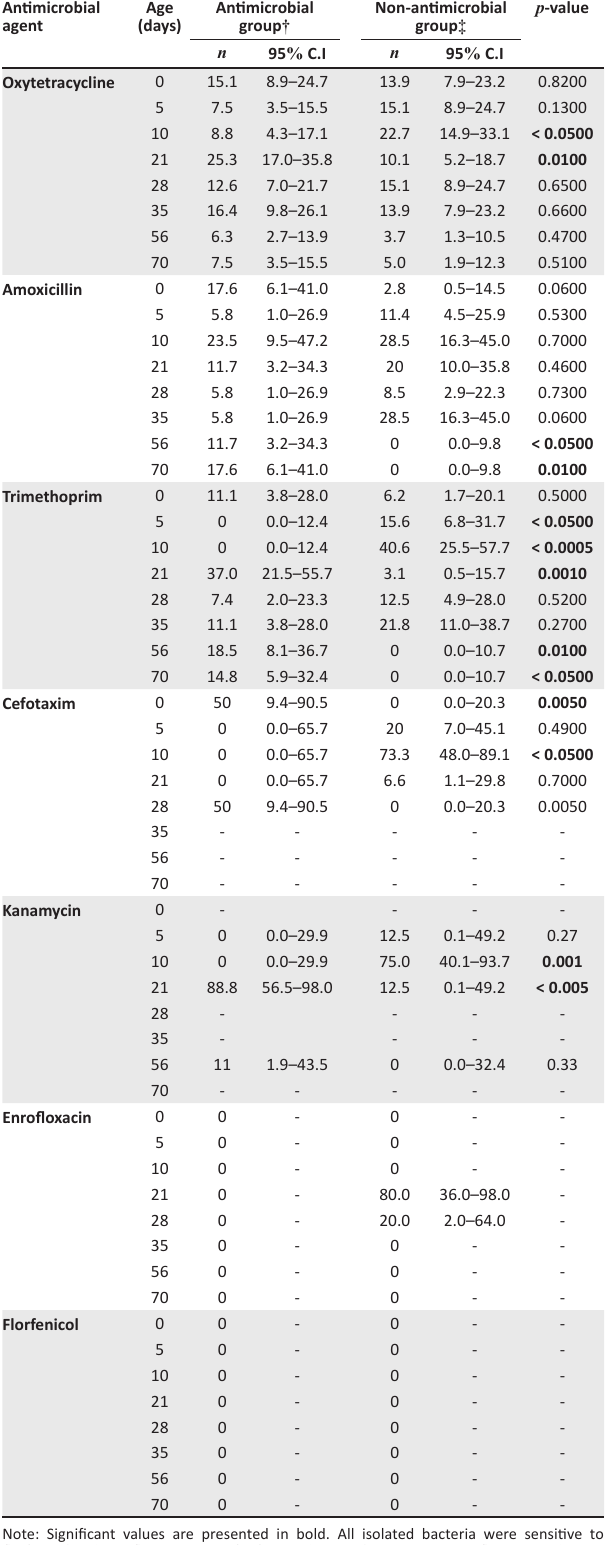
TABLE 4: Frequency of occurrence of phenotypic antimicrobial resistance during the growing period. Antimicrobial Age Antimicrobial agent (days) group